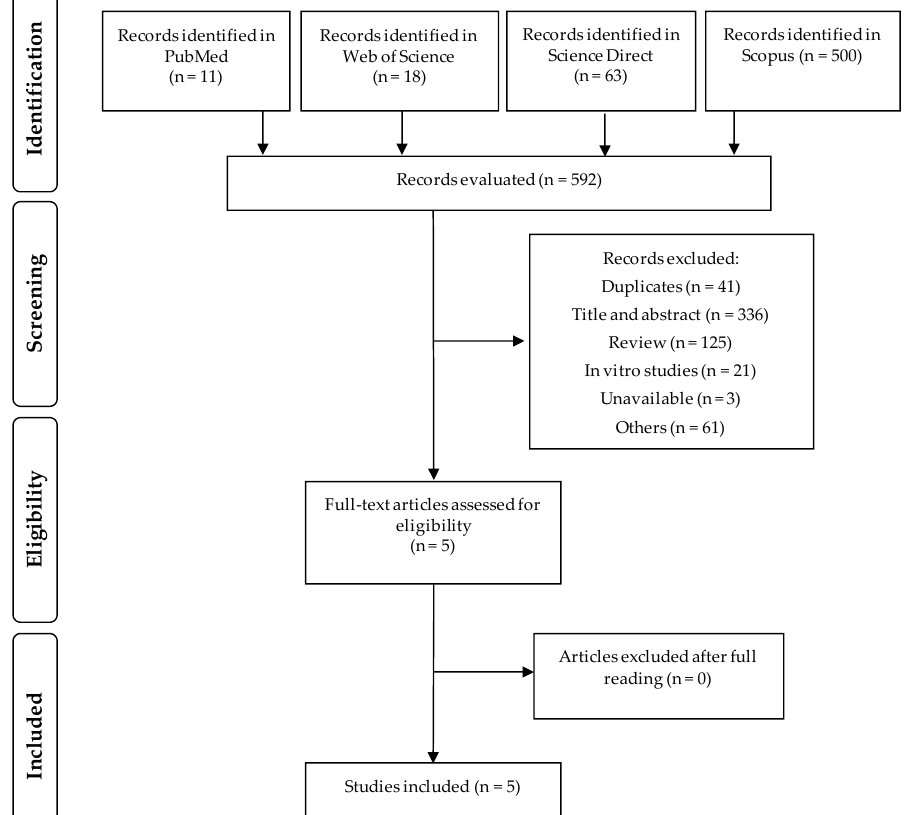
Figure 1. Flow diagram of the literature search process.